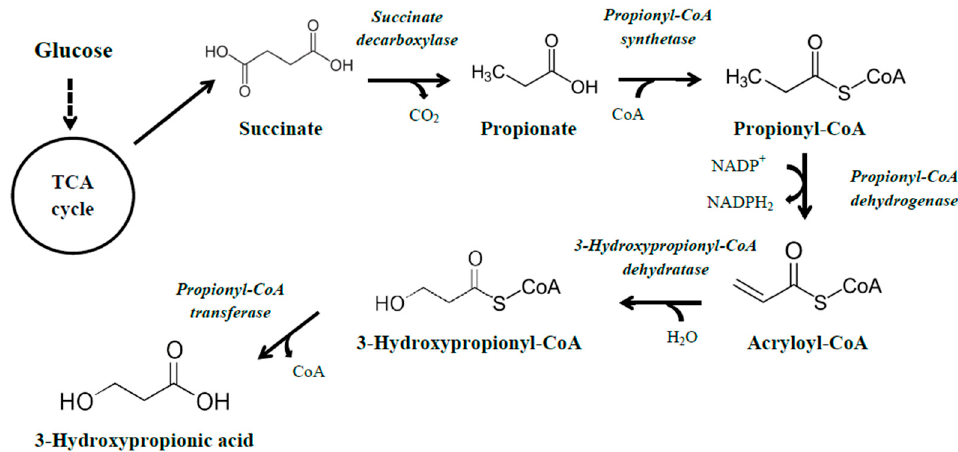
Figure 5. Conversion of glucose to 3HP through the propionyl-CoA pathway.